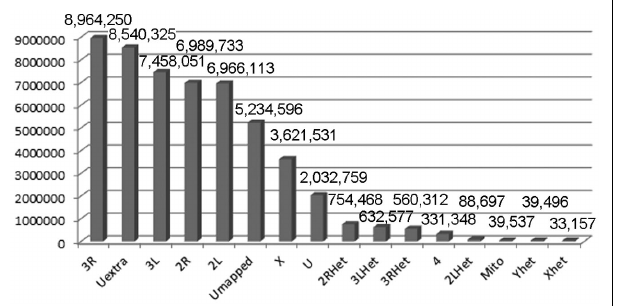
FIGURE 1 | Mapping X1 to the reference genome. The reference genome used was the latest FlyBase version (dm5.30).The quality score was arbitrarily set at 70 and above for this table.The numbers indicate the numbers of reads mapped to the indicated genomic region. U, unmapped regions. Het, heterochromatic